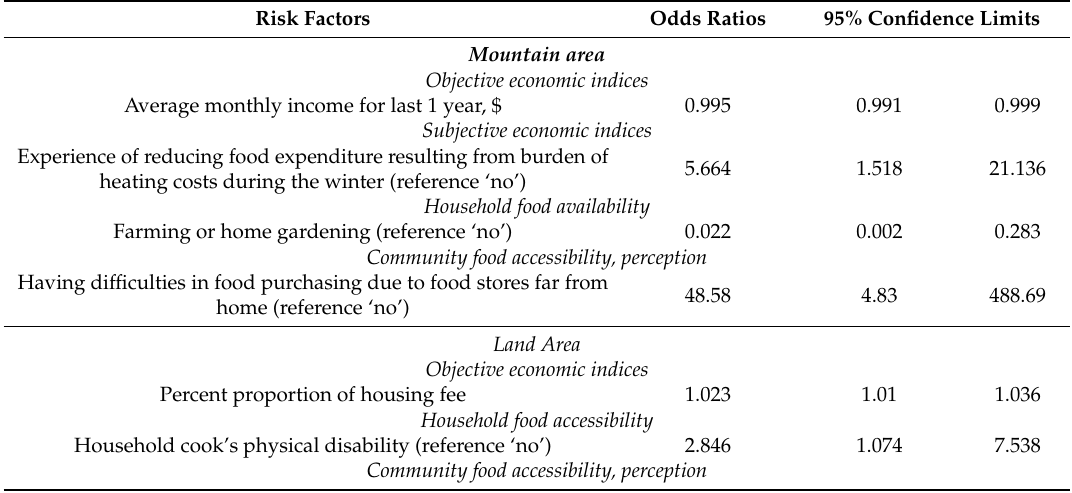
Table 4. Risk factors for food insecurities in two rural areas with different demographic, economic, and food environment